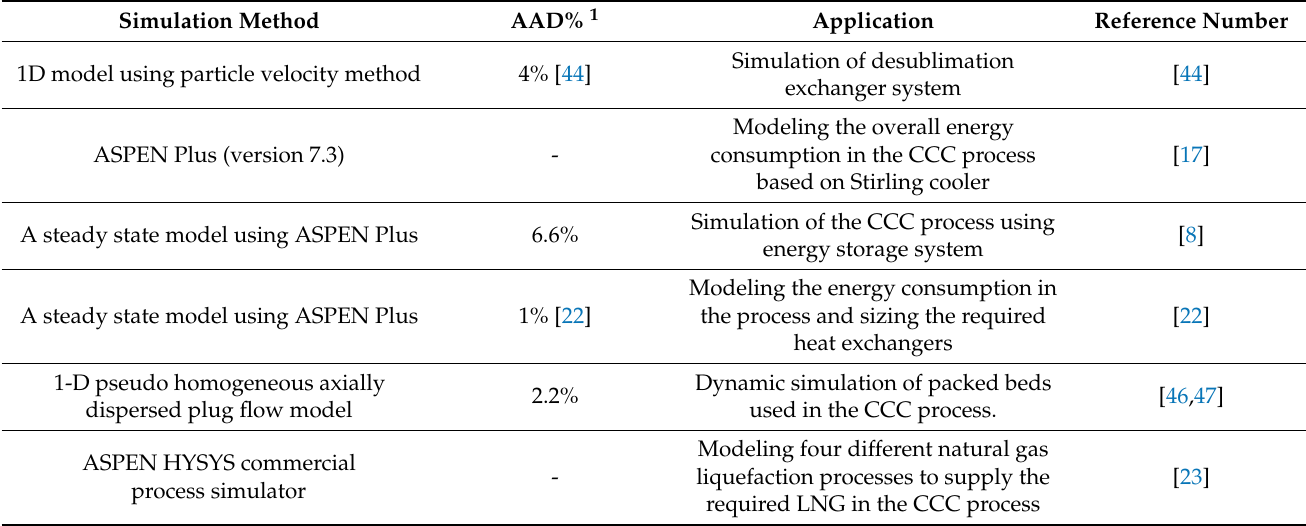
Table A1. The Available Methods and Their Accuracy for Modeling Different Components in the CCC